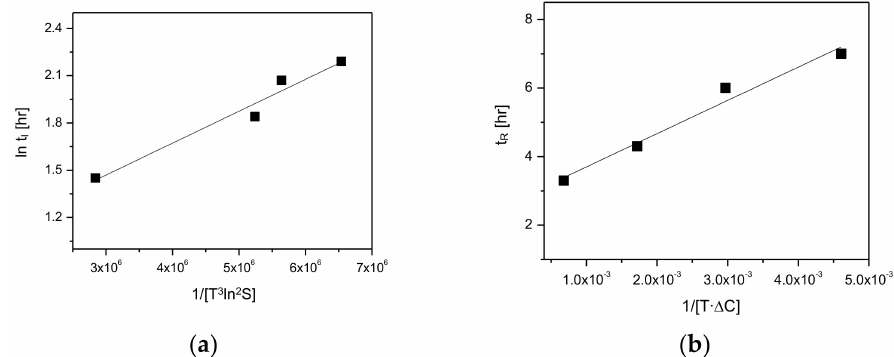
Figure 12. Kinetic correlation of ( a ) the induction time of the polymorphs in phase transformation based on Volmer’s nucleation model, ( b ) reconstruction time of the polymorphs in phase transformation based on the film theory mass of transfer